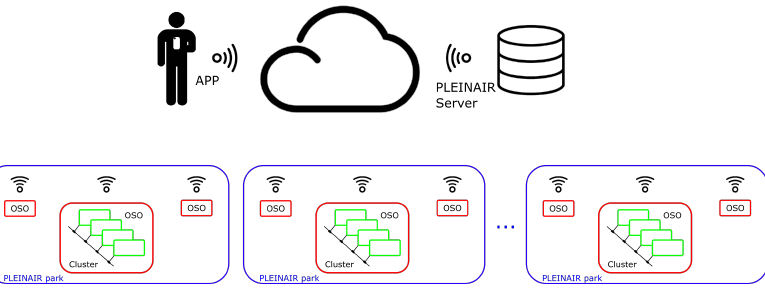
Figure 8. General view of the PLEINAIR system